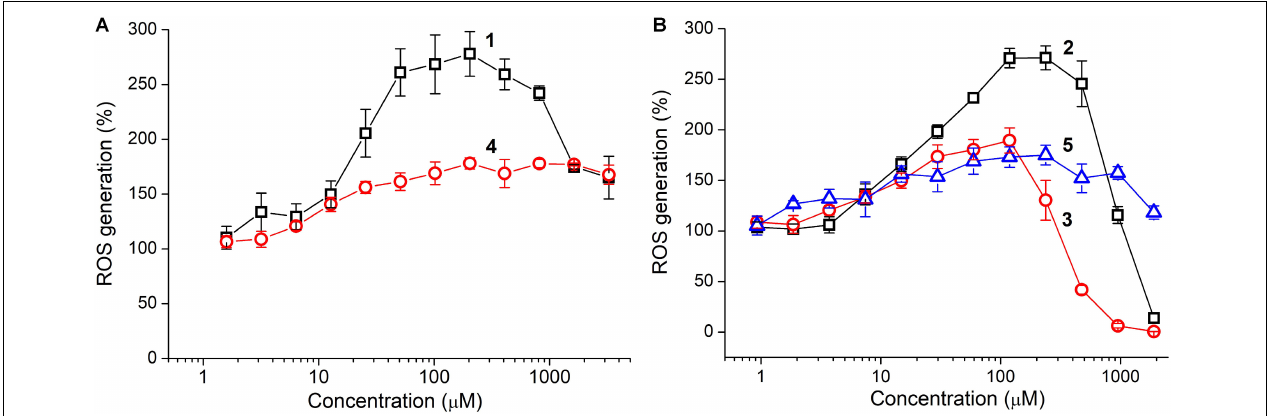
FIGURE 3 | Concentration–dependent effect of oligopeptides on ROS generation in CoCl 2 /H 2 O 2 reaction: (A) YRFK-NH 2 (1), YrFK-NH 2 (4) and (B) TPP-3-YRFK-NH 2 (2), TPP-6-YRFK-NH 2 (3), TPP-6-YrFK-NH 2 (5). ROS were detected by using DCFDA fluorescent probe (5 µ M) at λ ex = 488 nm and λ em = 535 nm. Mean ± SD ( n = 3) are shown.